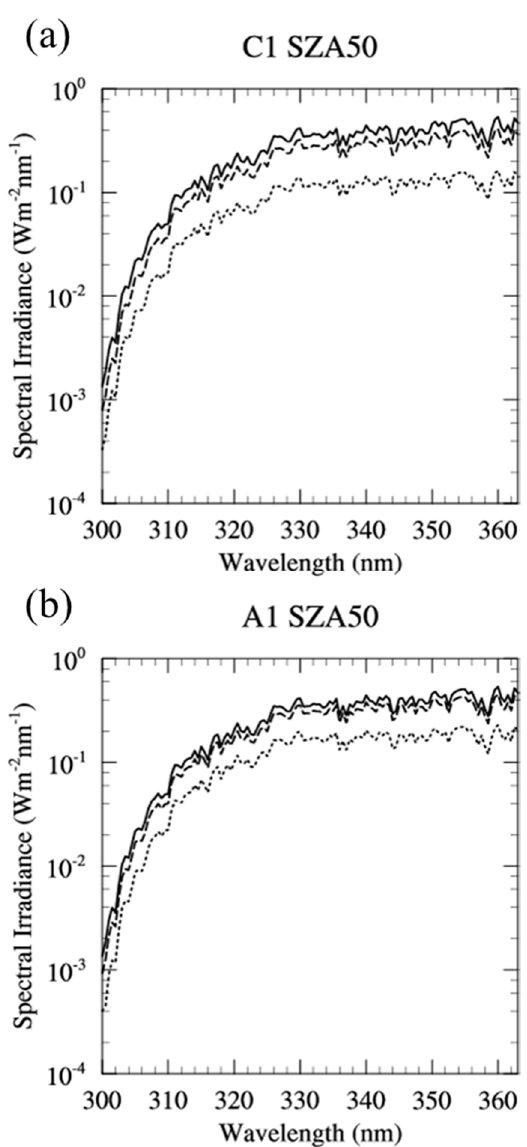
Figure 4. Maximum (Bold), minimum (dotted), and mean (dashed) value of spectral irradiance in ultraviolet (UV) after correcting the ozone absorption based on the total ozone of 300 Dobson Unit (DU) for: ( a ) C1; and ( b ) A1 cases.